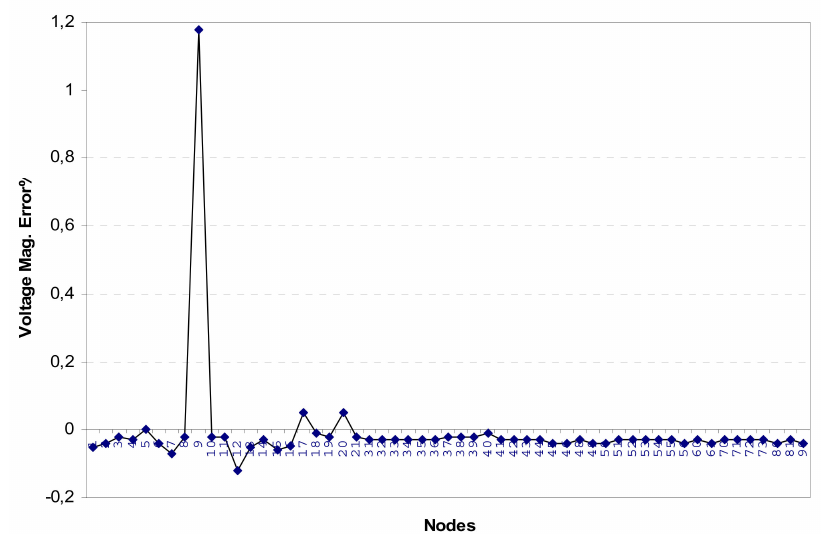
Figure 4. Percent error of the estimated bus voltage magnitudes considering gross errors on the active and reactive load of bus 9.